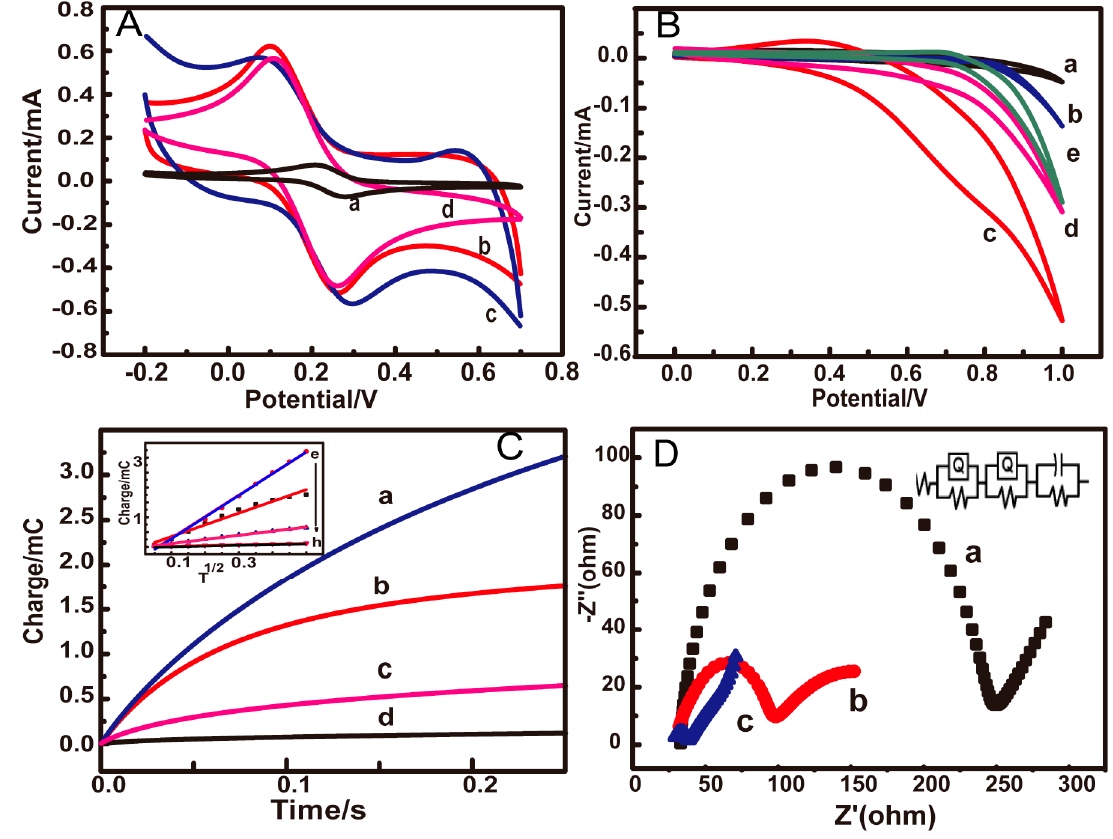
Figure 4. ( A ) The cyclic voltammograms (CVs) of (a) bare ITO; (b) PCL@PPy/ITO; (c) Cu/PCL@PPy/ITO; and (d) CuO/PCL@PPy/ITO in 0.1 M KCl solution containing 0.5 mM K 3 [Fe(CN) 6 ] with the scan rate of 50 mV/s; ( B ) CVs of (a) bare ITO; (b) PCL@PPy/ITO; (c) CuO/PCL@PPy/ITO and (d) Cu/PCL@PPy/ITO electrodes in 0.01 M NaOH solution with 0.1 mM glucose; (e) CuO/PCL@PPy/ITO in 0.01 M NaOH solution without glucose, at a scan rate of 50 mV s − 1 ; ( C ) Plot of Q-t curves of (a) Cu/PCL@PPy/ITO; (b) PCL@PPy/ITO; and (c) CuO/PCL@PPy/ITO; (d) bare ITO in 0.1 M KCl soulution containing 0.5 mM K 3 [Fe(CN) 6 ] (Inset of C: plot of Q-t 1/2 curves on (e) Cu/PCL@PPy/ITO; (f) PCL@PPy/ITO; (g) CuO/PCL@PPy/ITO and (h) bare ITO); ( D ) the Nyqist plots of the EIS of the (a) ITO; (b) CuO/PCL@PPy/ITO; and (c) PCL@PPy/ITO electrodes in 0.1 M KCl solution containing 0.5 mM K 3 [Fe(CN) 6 ].